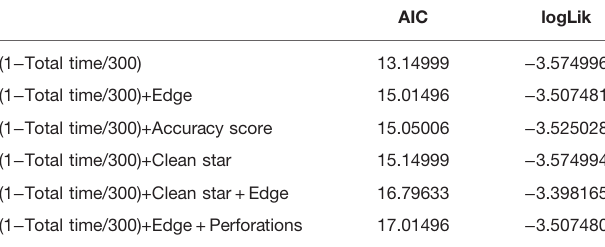
TABLE 2 | Summary of best selective model function for discrimination between novice and expert